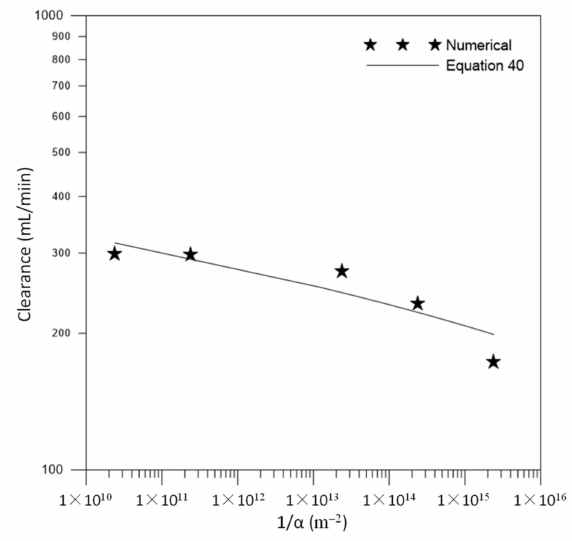
Figure 10. Clearance as a function of membrane viscous resistance.